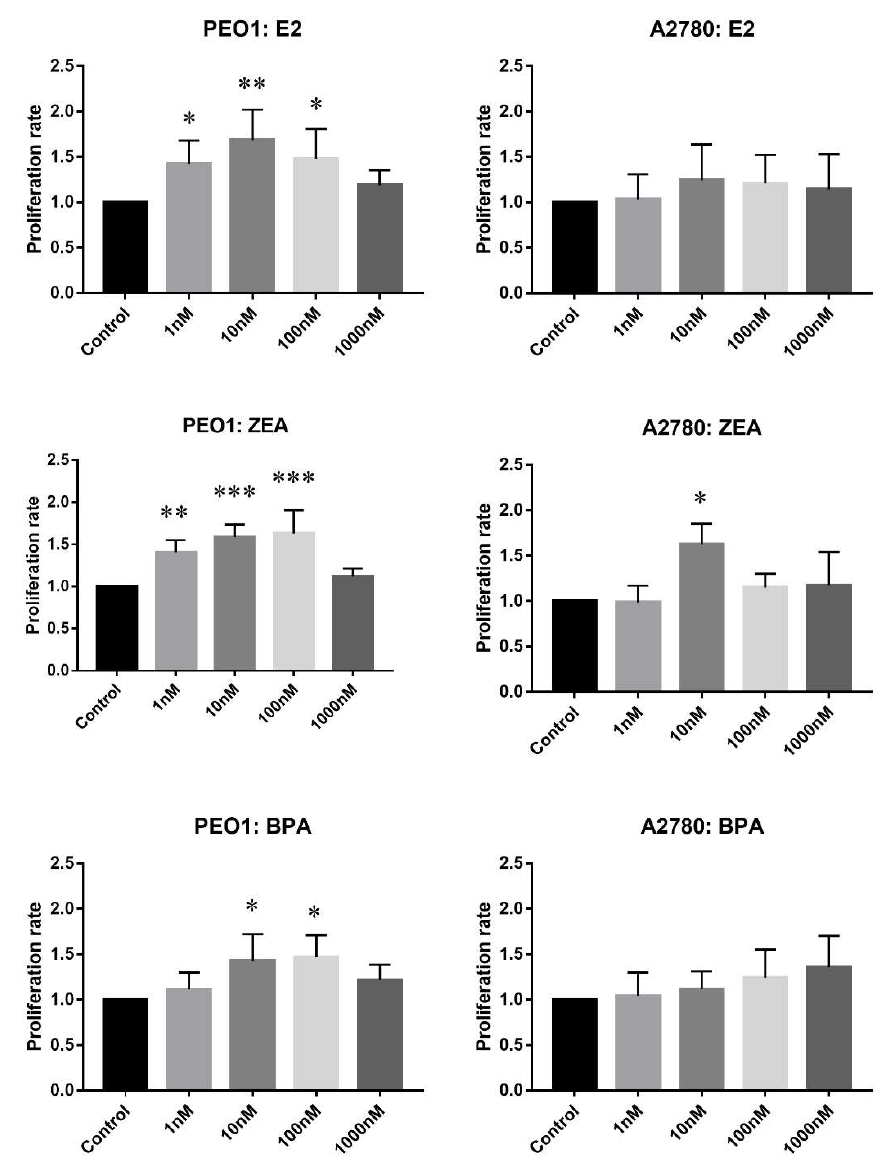
Figure 1. Effect of E2 (estradiol), ZEA (zeralaenone) and BPA (bisphenol A) on the proliferation of PEO1 and A2780 cell lines. Proliferation rate was determined by cell counting after the addition of 1, 10, 100, 1000 nM E2, ZEA and BPA. Cell count in case of the non-treated wells was regarded as 1. Data are presented as mean ± S.D. Significance was determined relative to the non-treated control: * p < 0.05; ** p < 0.01; *** p < 0.001.